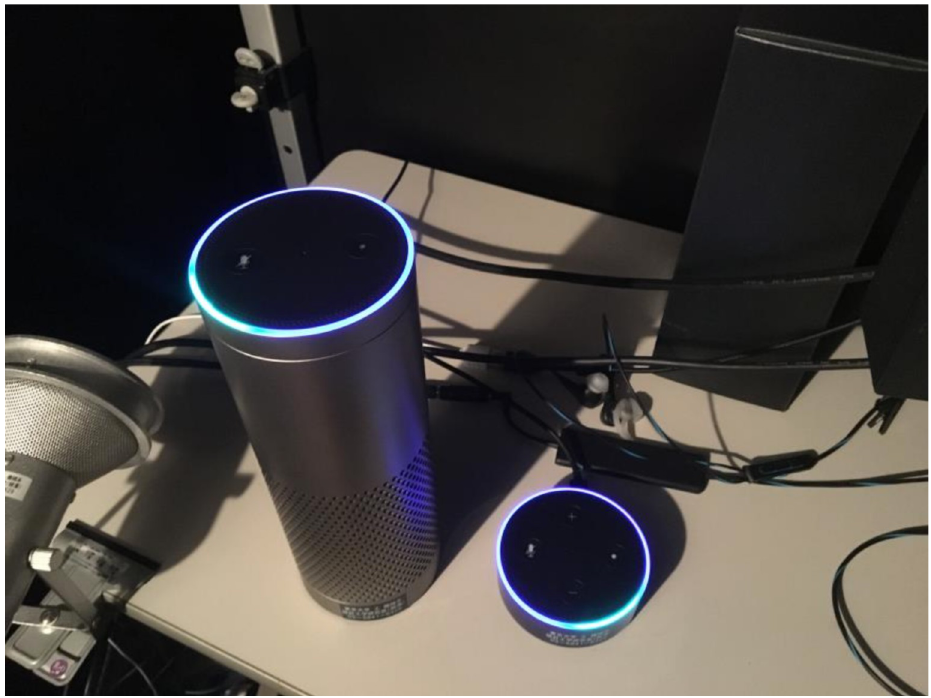
Fig 3. Smart speakers used for experiment. Amazon Echo Plus (left) and Amazon Echo Dot (right).